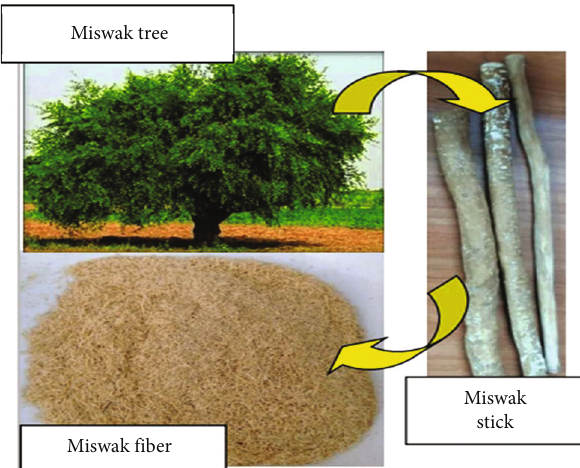
Figure 2: Miswak fi ber obtained from miswak stick that originated from miswak tree.